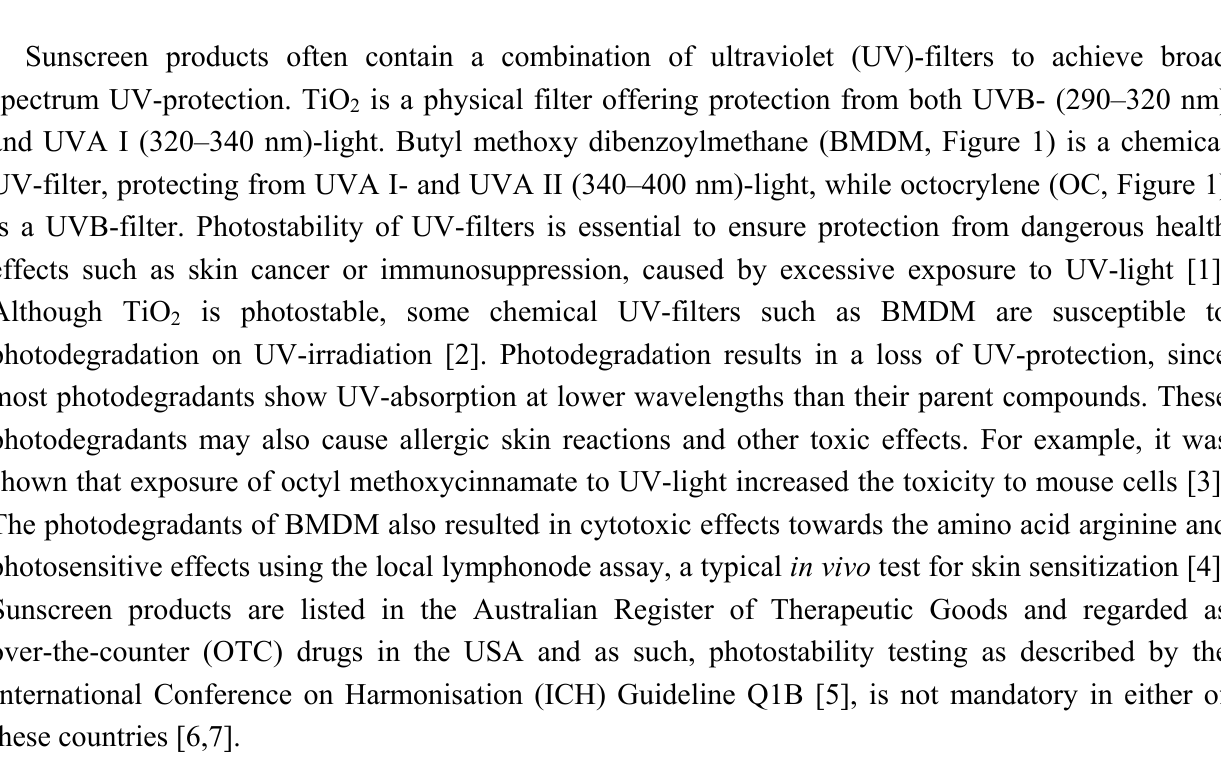
Figure 1. Chemical structures of butyl methoxy dibenzoylmethane (BMDM) and octocrylene